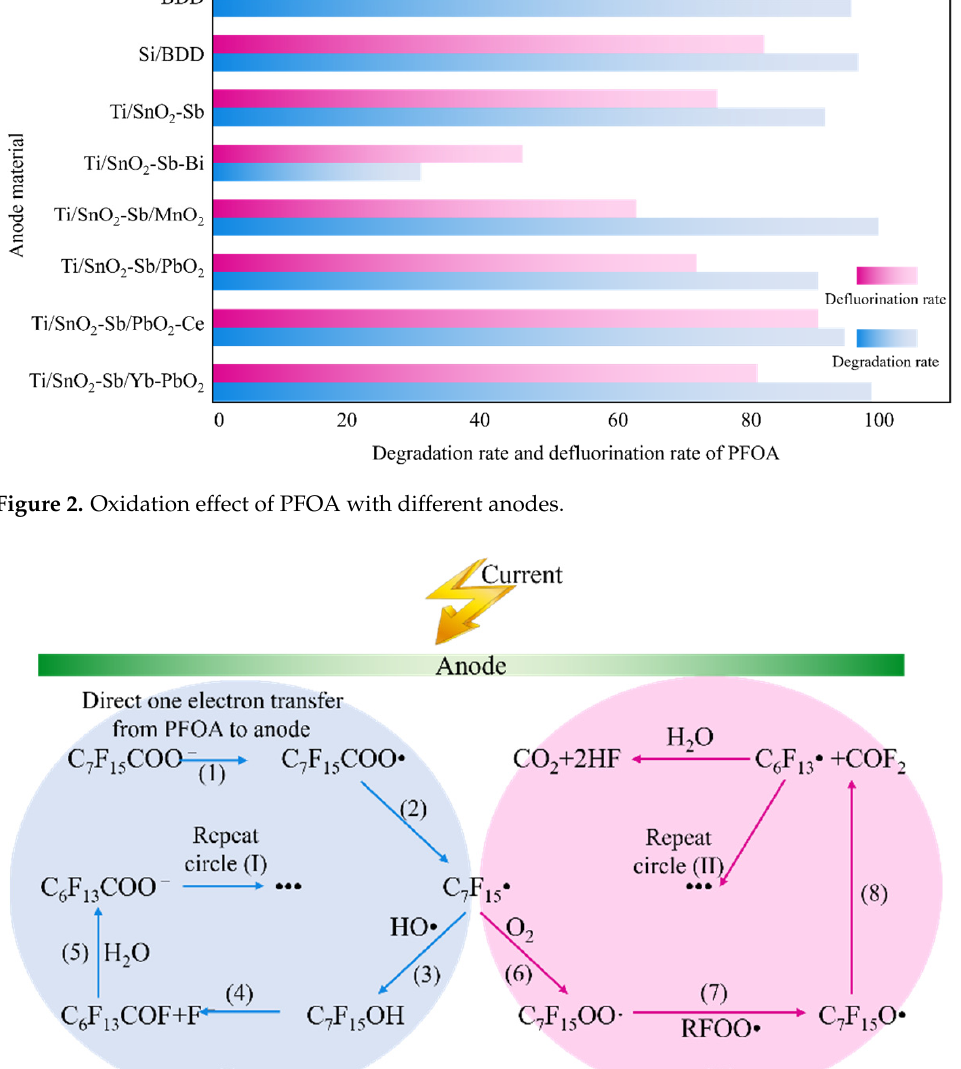
Figure 3. Oxidation mechanism of PFOA on the Ti/SnO 2 − Sb − Bi electrode. Reprinted with permis ‐ sion from reference Qiongfang Zhuo, Shubo Deng, Bo Yang, Jun Huang, Gang Yu, 2011, [128].